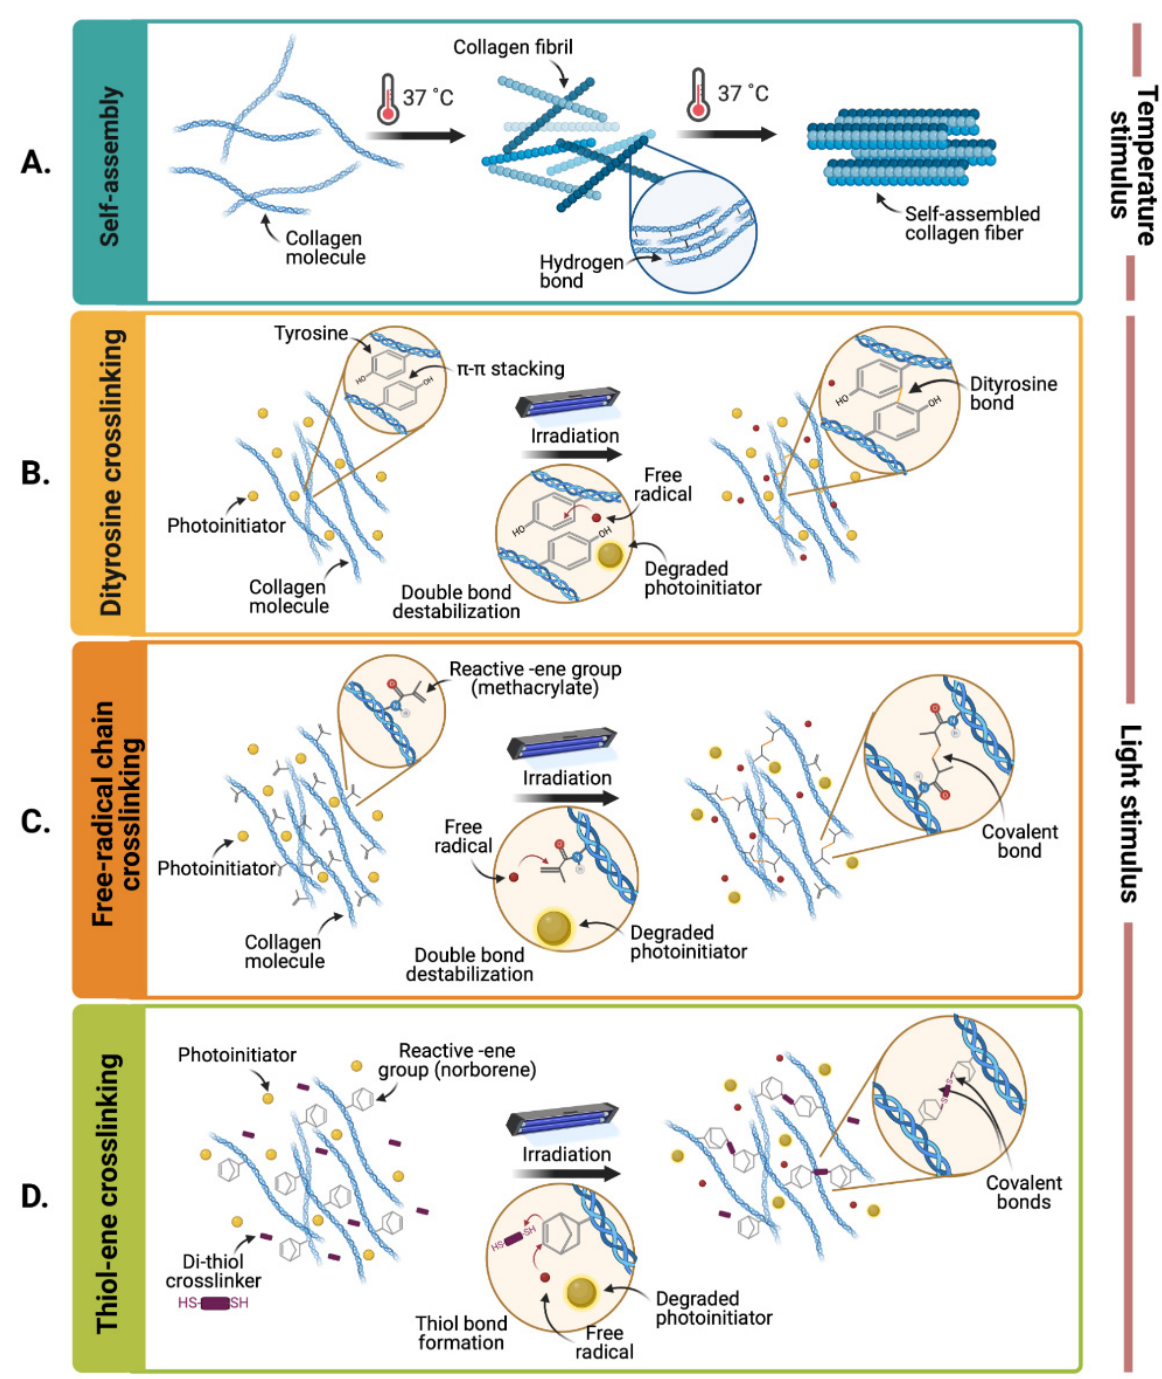
Figure 1. Hydrogel crosslinking upon thermal and light stimuli. ( A ) Self-assembly of collagen molecules upon thermal stimulus. ( B ) Photo-induced crosslinking between tyrosine residues, ( C ) methacryloyl, or ( D ) norbornene moieties (Created with BioRender.com).